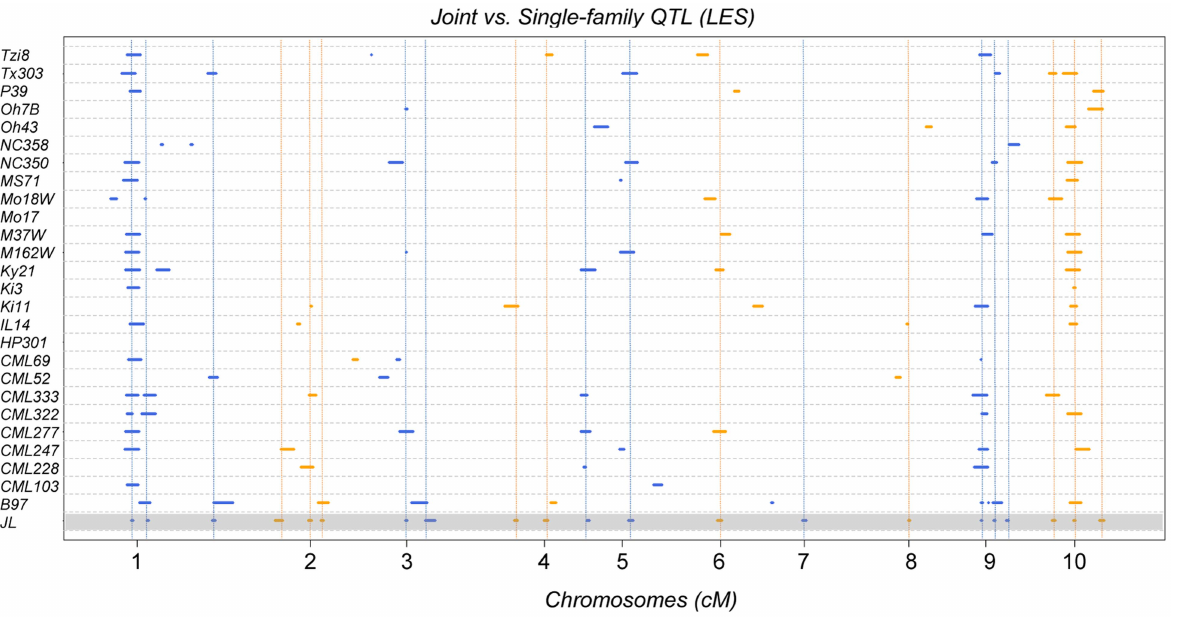
Figure 3. LES QTL obtained from single and joint-linkage QTL analysis across all the 10 maize chromosomes/linkage groups. Parental inbred lines crossed with the common B73 inbred line to derive each bi-parental sub-population are shown on the vertical axis. The results of joint linakage analysis across the NAM population comprising 24 populations is indicated as JL. The genetic distance for each chromosome is represented in cM (centi-Morgan) unit on the horizontal axis. Different colours are used to indicate alternating chromosomes.